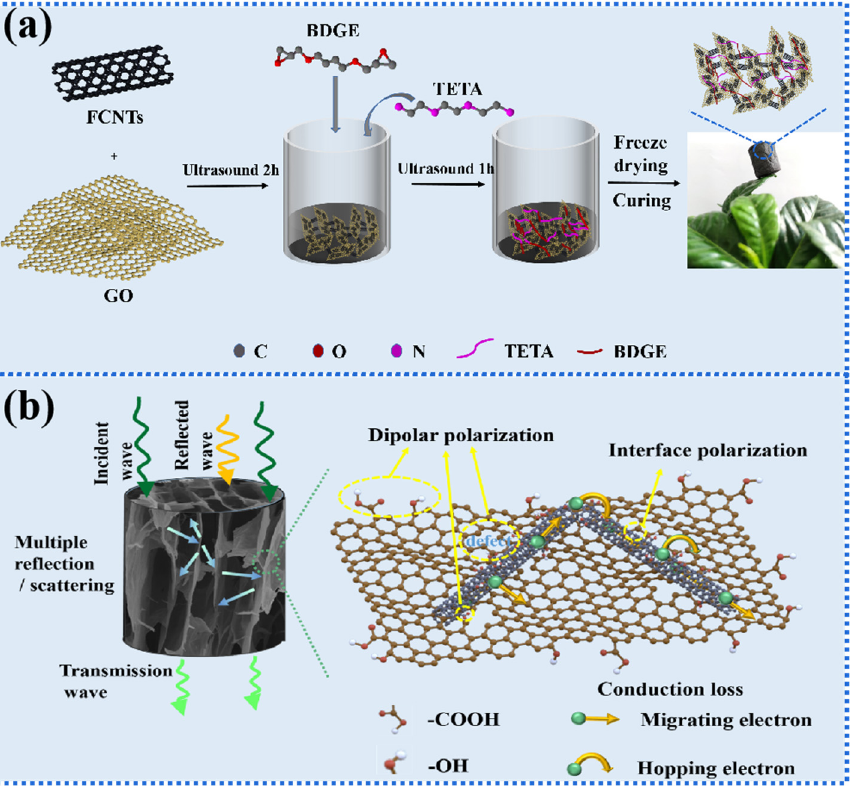
Figure 10. ( a ) Synthesis procedures, ( b ) schematic illustration of EM absorption mechanisms of GCEA composite aerogels (Color figure can be viewed online).